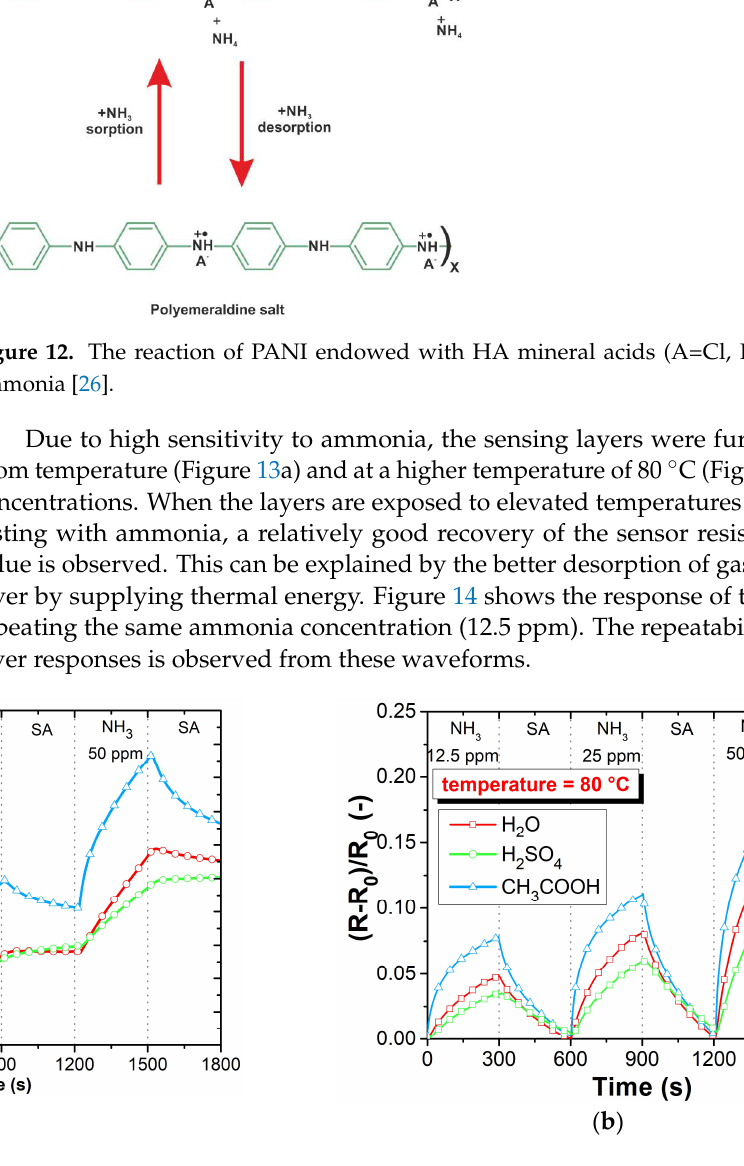
Figure 13. Gas characterization of active layers toward ammonia: ( a ) various concentrations at room temperature, ( b ) various concentrations at 80 °C.